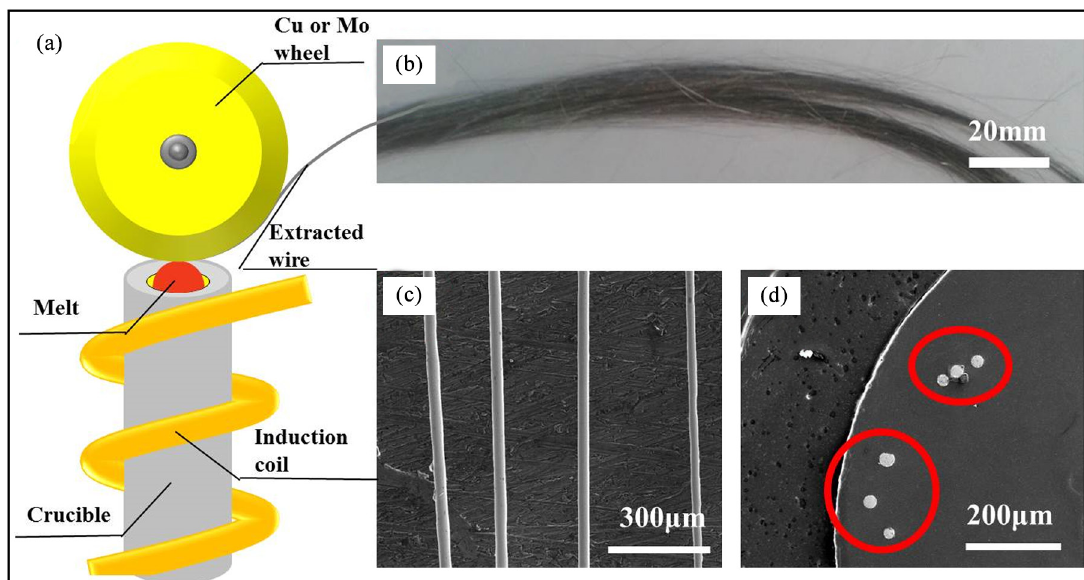
Figure 1. (a) Schematic diagram of the melt-extraction process, (b) optical micrograph of as-extracted microwires bundle, SEM images of (c) side-view and (d) circular